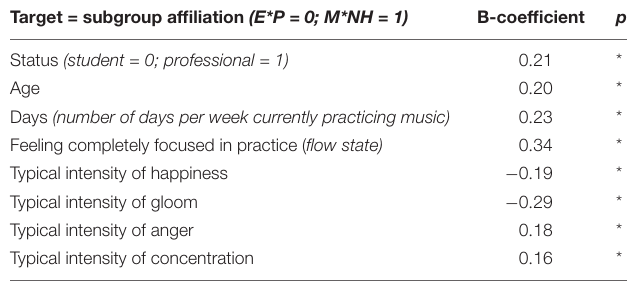
TABLE 9 | Variables included in the final CATREG